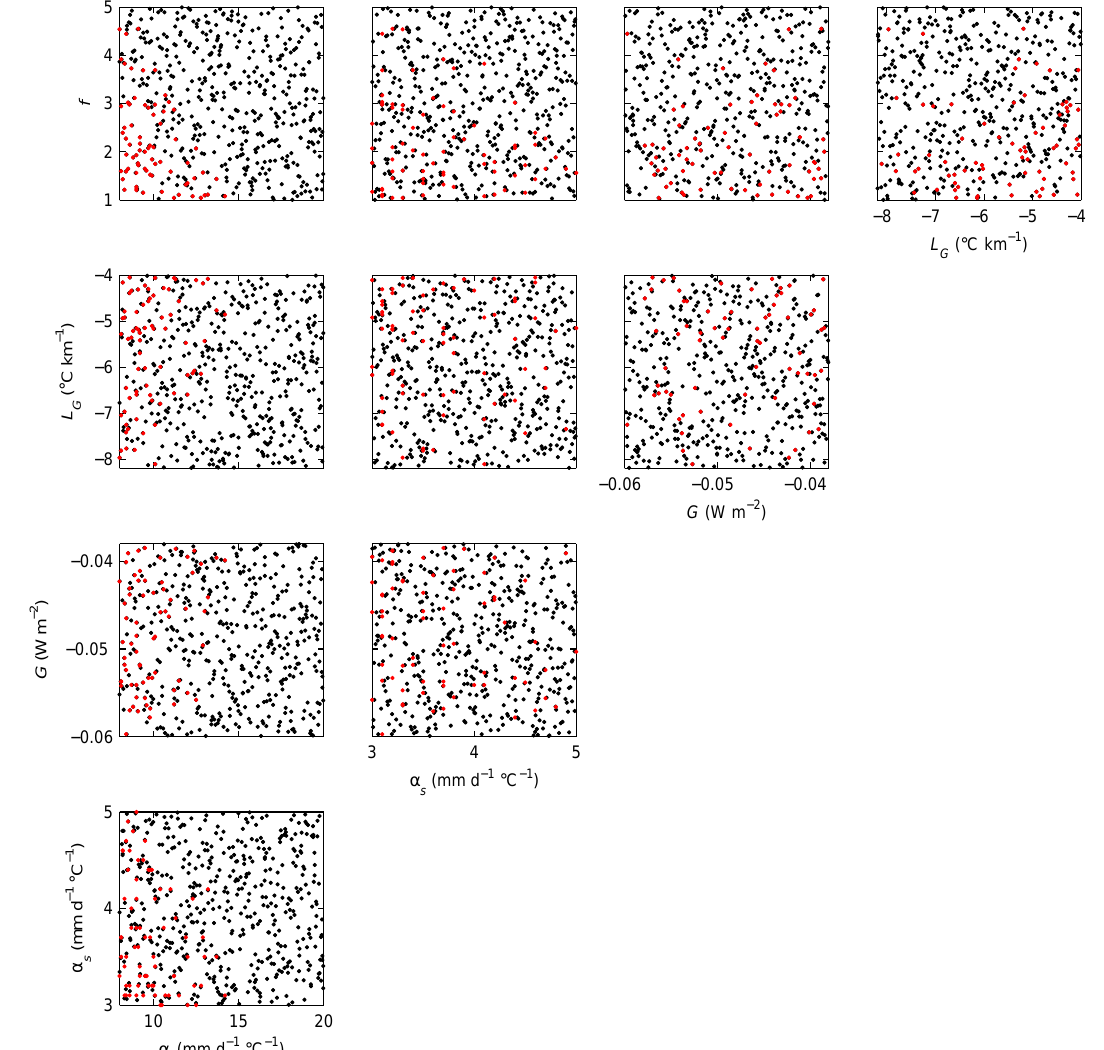
Fig. 1. Distribution of 500 Glimmer parameter experiments produced by Latin hypercube sampling and projected onto two-dimensional slices through the five-dimensional space. The parameters are as follows: the geothermal heat flux ( G) , the positive degree day (PDD) factor for snow ( α s ) , the PDD factor for ice ( α i ) , the atmospheric vertical lapse rate ( L G ) and the enhancement flow factor ( f ) . The experiments highlighted in red are those which are valid for the